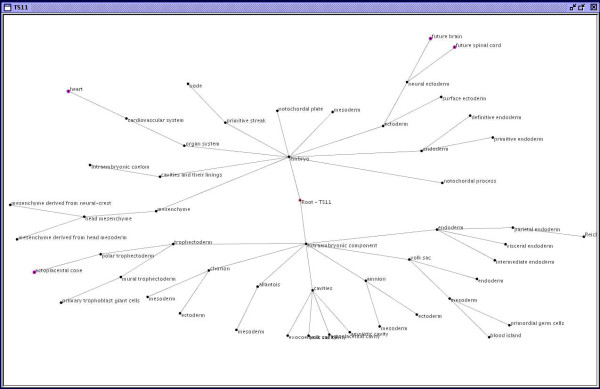
The equivalent radial layout for TS11 drawn In Figure 6. There is more uniform distribution of nodes for this layout than for the L-R or T-D. This reduces the problem of high density of nodes in areas of the L-R and T-D layouts while other areas remain largely unoccupied.